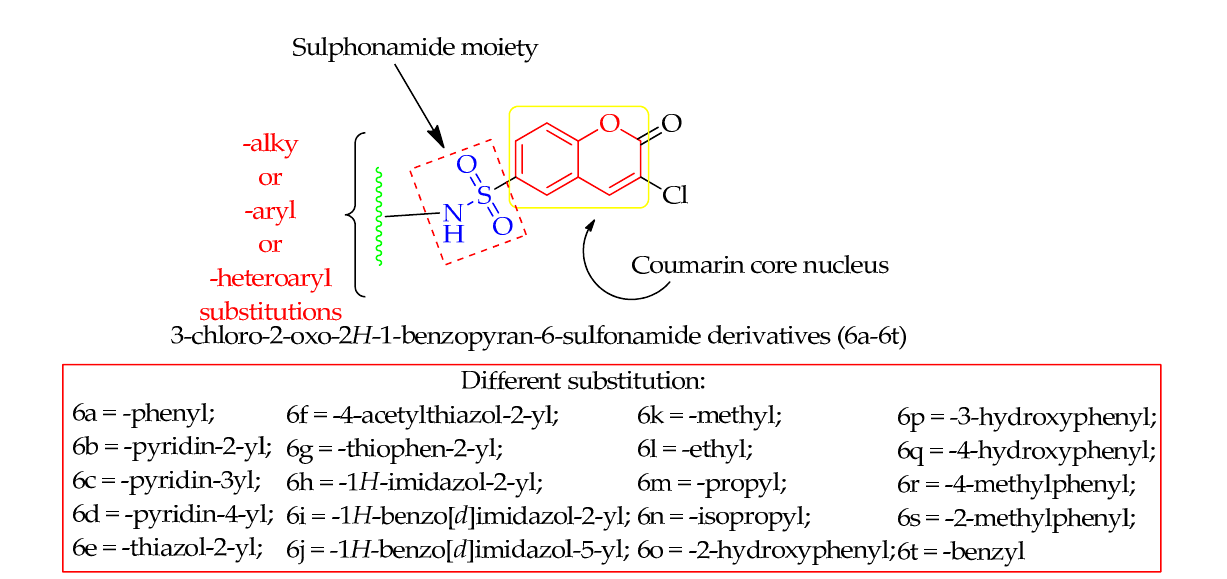
Figure 2. Designing an approach to develop some Coumarin ‐ based sulphonamide derivatives as DPP ‐ IV inhibitors.